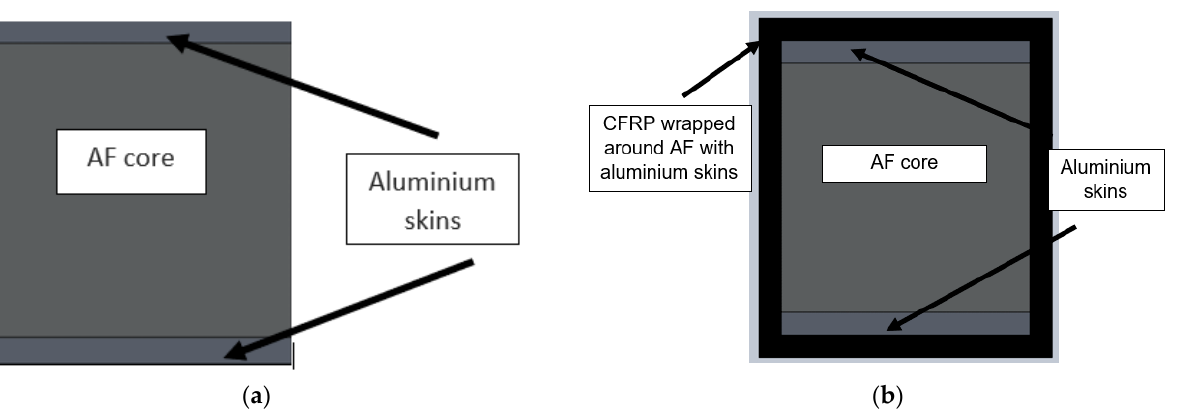
Figure 14. ( a ) The CAD model for the FE simulation of AFSS; ( b ) AFSS wrapped around four-layer CFRP (XPREG ® XC110 3K).